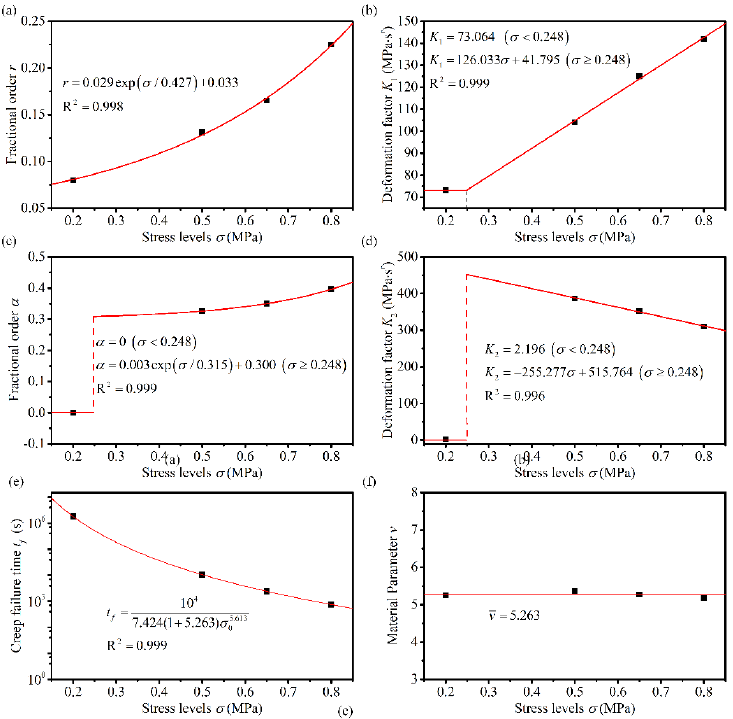
Figure 9. Variation of the proposed model parameters with stress levels at 30 °C ( a ) r , ( b ) K 1 , ( c ) α , ( d ) K 2 , ( e ) t f , and ( f ) v .